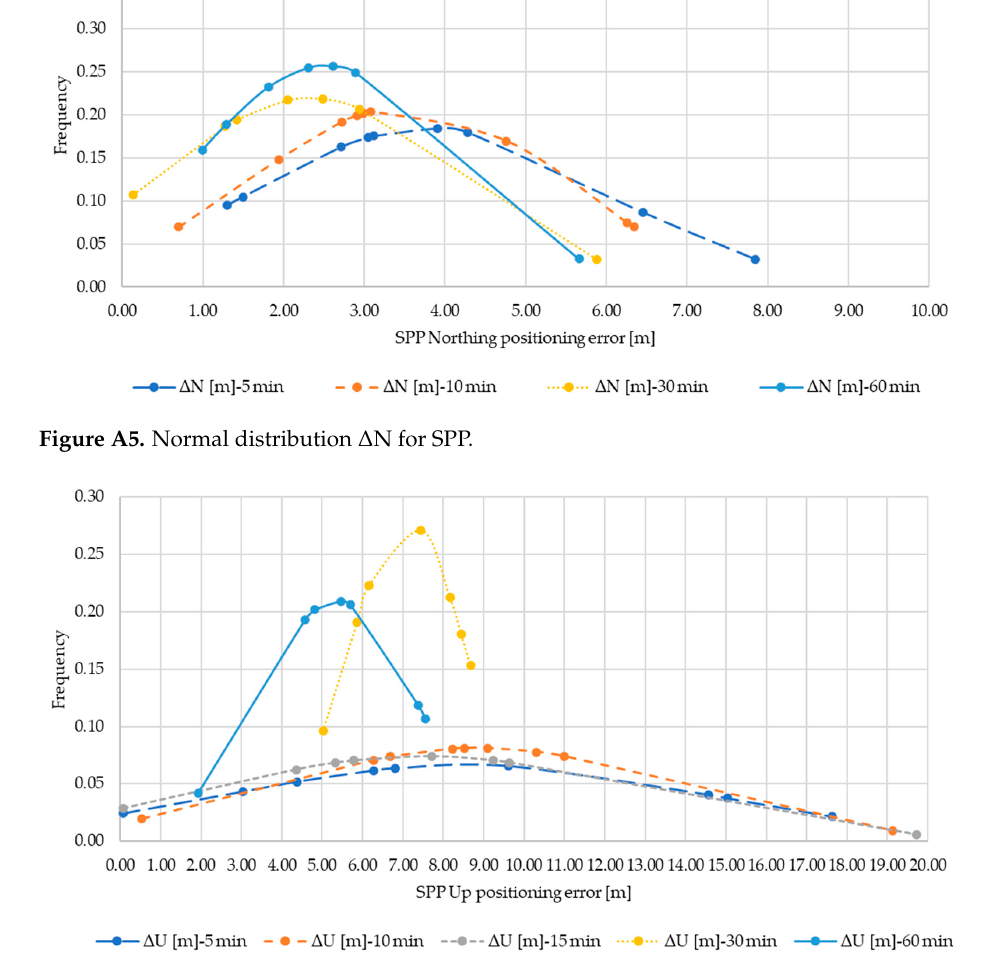
Figure A6. Normal distribution Δ U for SPP.